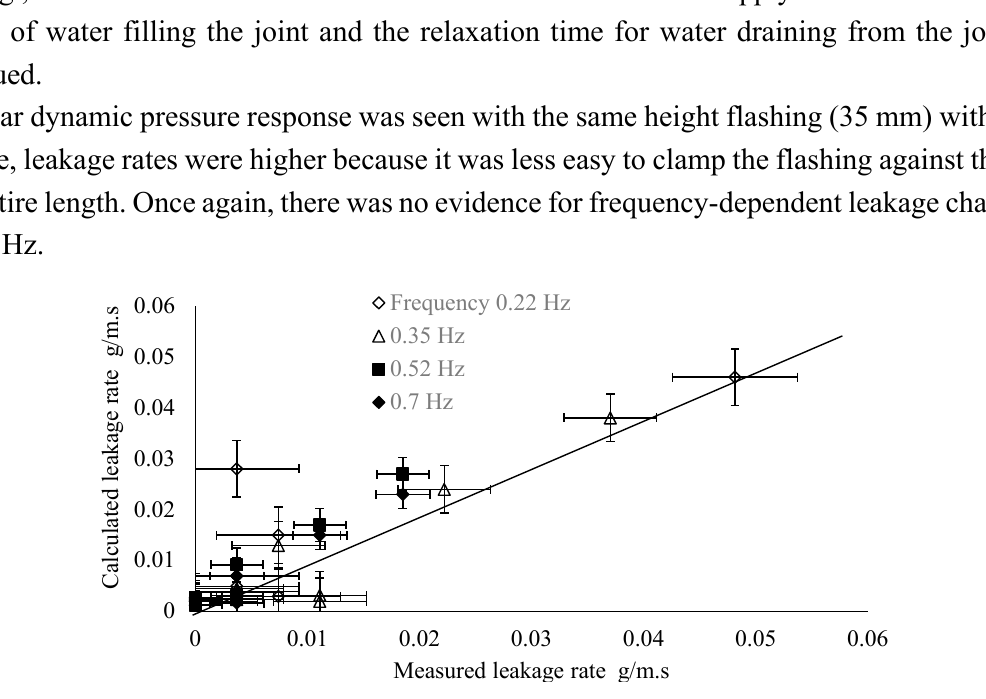
Figure 8. A comparison of measured and calculated leakage rates with fluctuating air pressures and showing experimental uncertainties.